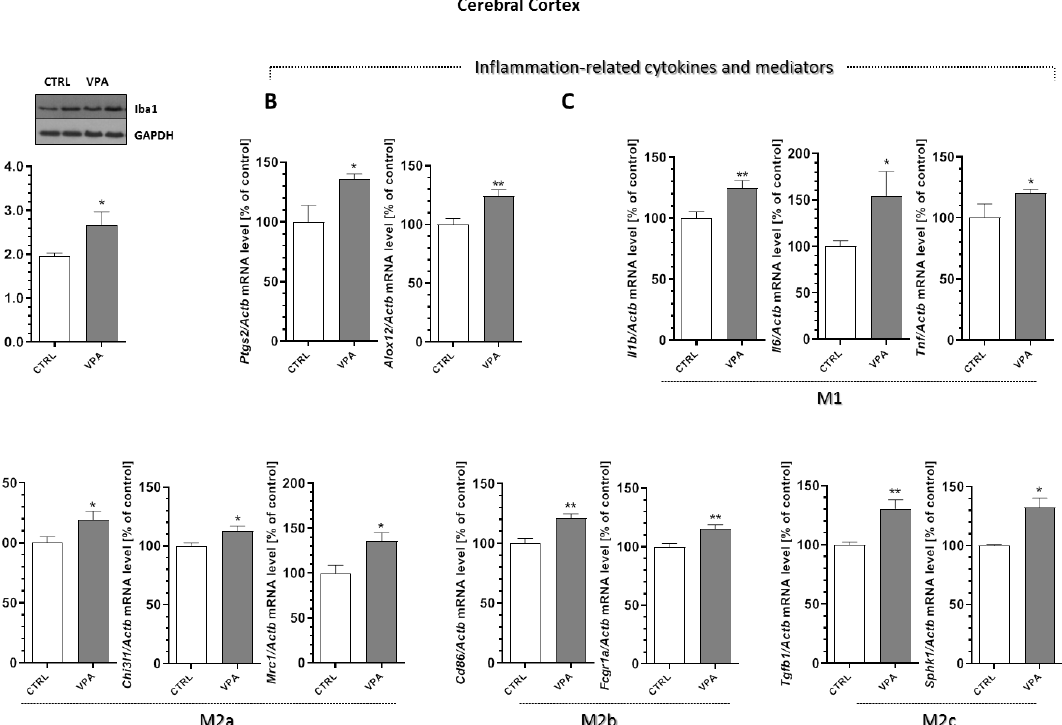
Figure 10. The e ff ect of prenatal exposure to VPA on the status of microglia in the cerebral cortex. ( A ) The immunoreactivity of Iba-1 was monitored using a Western blot analysis. Densitometric analysis and representative pictures are shown. Results were normalized to GAPDH levels. Data represent the mean values ± SEM from n = (8–11) independent experiments. The gene expression of Ptgs2, Alox12 ( B ); Il1b, Il6, and Tnf ( C ); and the markers of the M2 phenotype’s microglia activation: Arg1, Chi3l1, Mrc1, Cd86, Fcgr1 α , Tgfb1, and Sphk1 ( D ) in the cerebral cortex of the control and VPA-exposed rats were measured with quantitative RT-PCR and calculated by the ∆∆ Ct method with Actb ( β -actin) as a reference gene. Data represent the mean values ± SEM for n = (3–6) independent experiments. * p < 0.5, ** p < 0.01 vs.